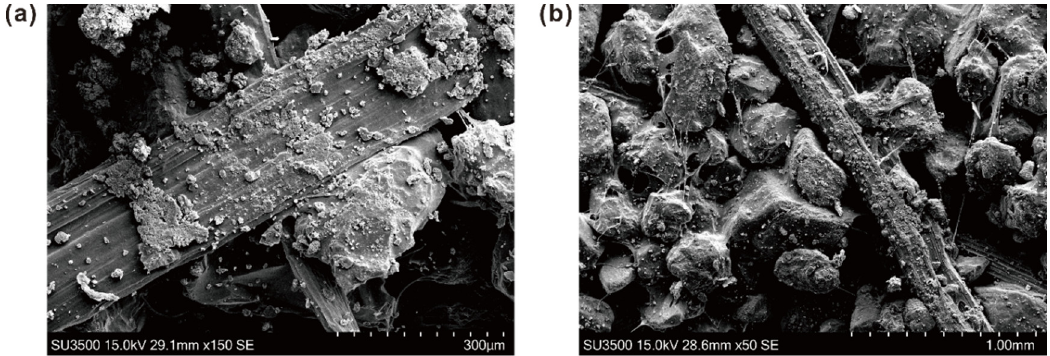
Figure 11. SEM images of fiber–polymer-reinforced sand ( p f = 0.6%, p p = 4%, and ρ d = 1.5 g/cm 3 ). ( a ) Fiber surface in polymer‐treated sand; ( b ) Interaction characteristics between fibers and sand particles.